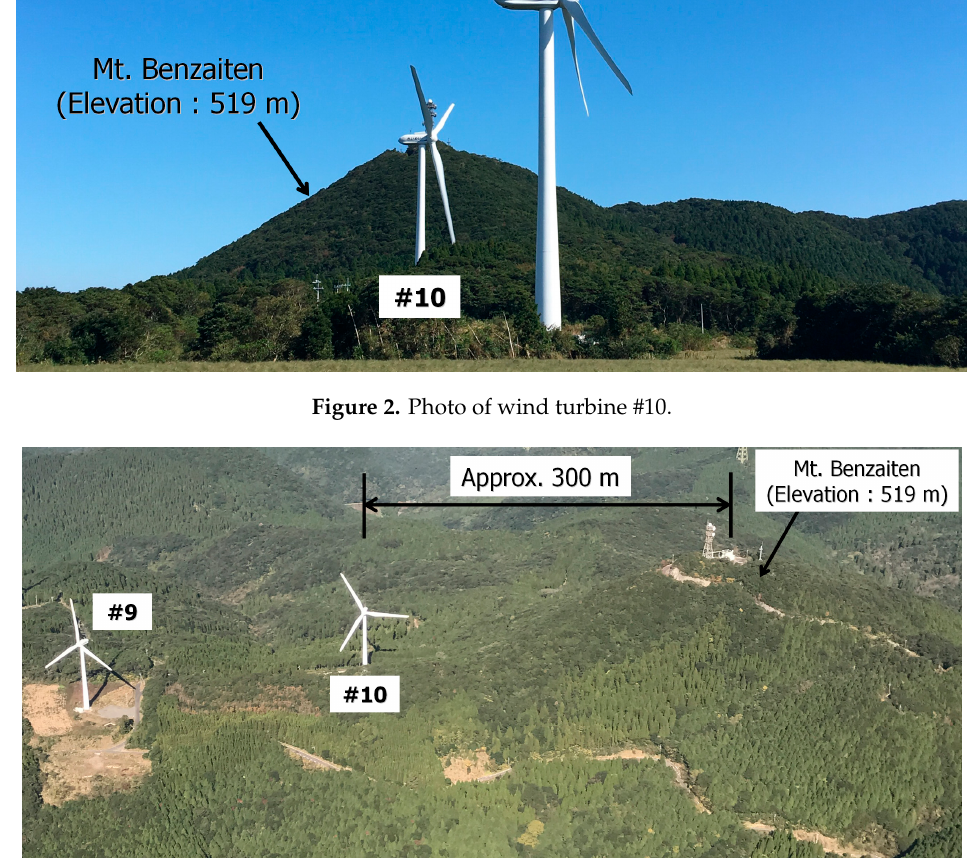
Figure 4. Outline of a wind turbine.